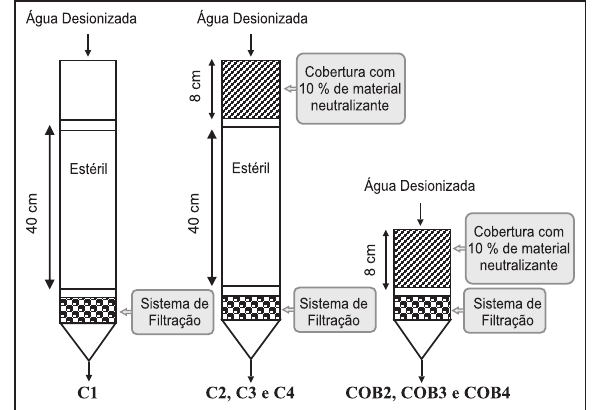
Figura 1. diagrama esquemático das colunas (C1, C2, C3, C4, Cob2, Cob3 e